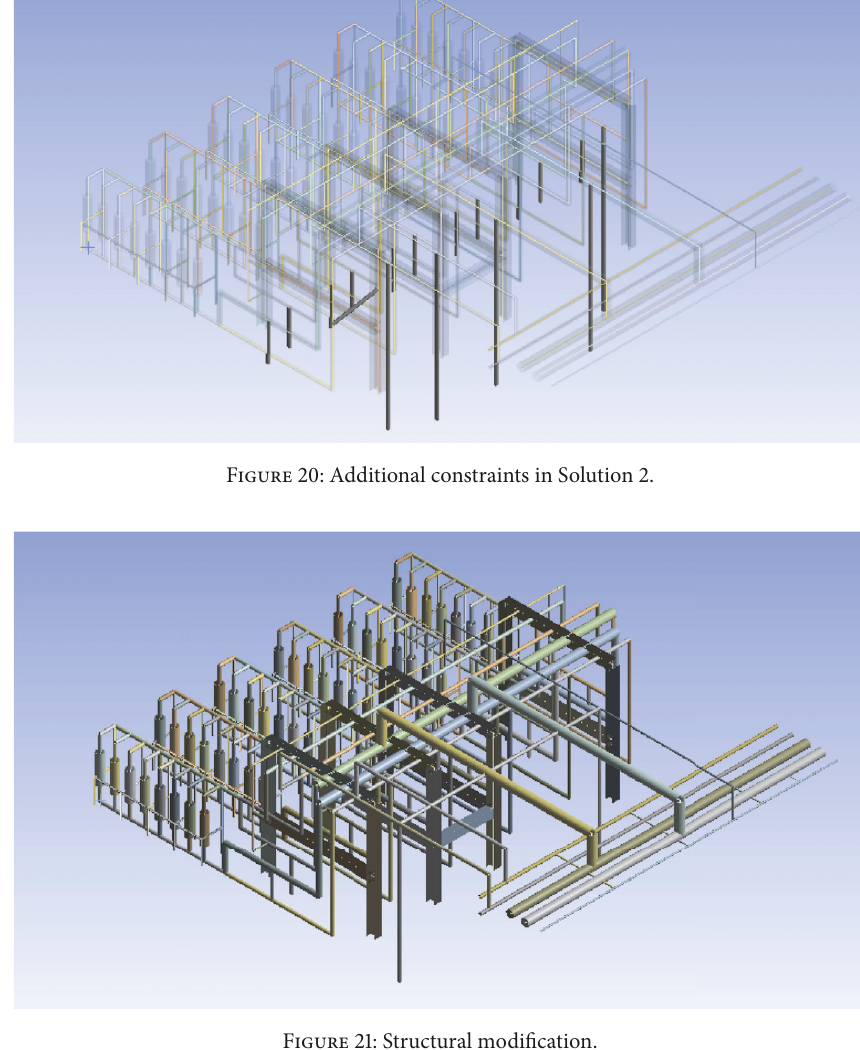
Figure 21: Structural